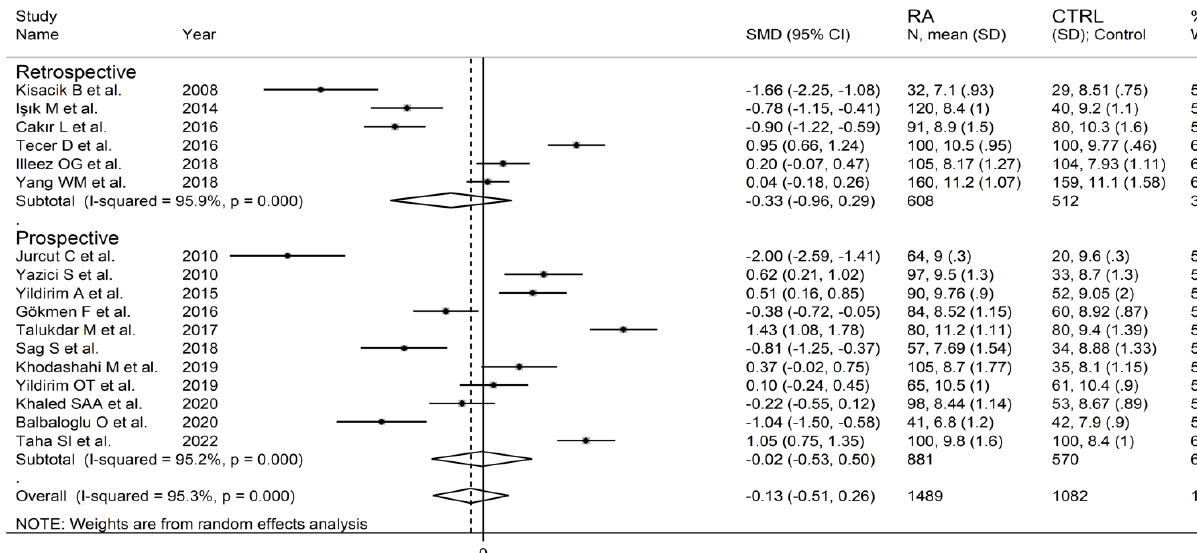
Figure 5. Forest plot of studies examining the mean platelet volume in patients with rheumatoid arthritis and healthy controls according to study design.